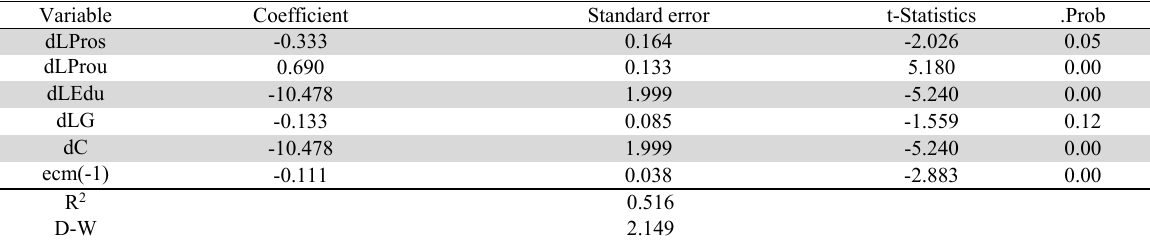
The Error Correction Mechanism without time trend Variable